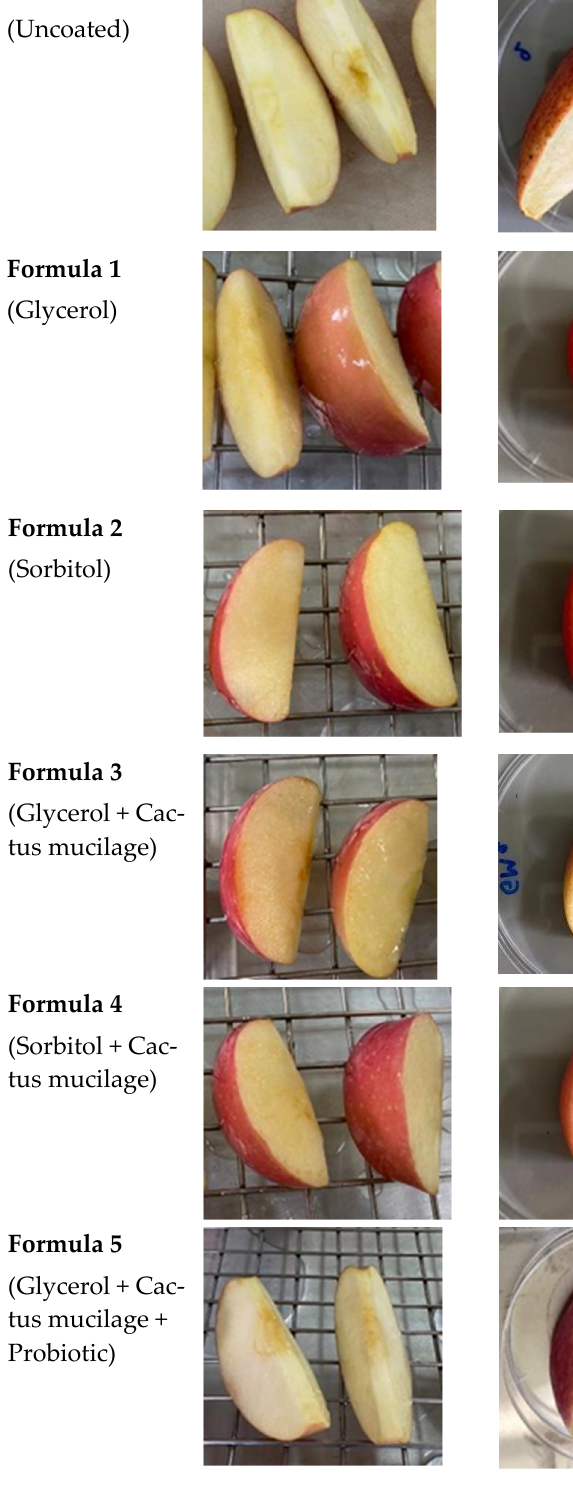
Figure 5. The appearance of fresh cut apple slices dipped in edible coating compared to the control (uncoated) after refrigeration at 4 ° C on days 0, 2, 5 and 7. In this study, the weight loss of fresh-cut apples with and without edible coatings was also evaluated (Figure 6). Significant weight loss occurred in uncoated fresh-cut ap- ples (control). Constant losses in weight were observed in all coated samples up to day 7, except for samples that were coated with the bioactive edible formula 5, which exhibited no significant reduction in weight at the end of 7 days of storage. Bioactive edible formula 6 also exhibited a protection against weight loss, though not to the same degree as formula 5. Previous studies reported weight loss of stored product was lower when yeasts of the species Cryptococcus laurentii were added in the coatings, suggesting that the addition of microorganisms can influence this aspect of food preservation [43]. Our result also sug- gested the lower WVP of formula 5, compared to formula 6 (Table 3), may help to counter water loss from the product. Reduction in product weight loss and darkening, as well as maintaining the freshness and extending the shelf life of fresh-cut products, are all